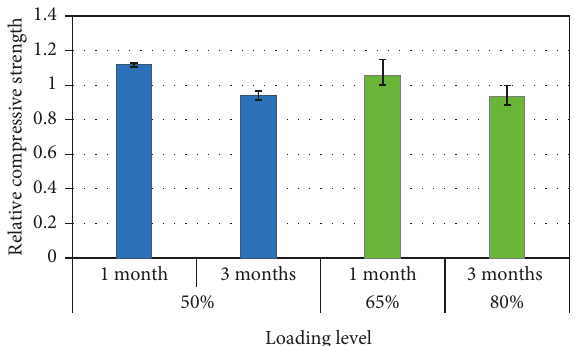
Figure 15: Tensile strength (relative to the average unloaded specimens) vs. the creep loading level and quasi-instantaneous preloading of specimens. The error bar represents the maximum and minimum relative strength values (for no less than 3 speci- mens). The variabilities of 3 accompanying unloaded specimens with respect to the creep-loaded specimens ranged between +0.14 and − 0.16, whereas the variabilities (no fewer than 3 accompanying specimens) correlated with quasi-instantaneous preloading were between +0.2 and − 0.3.